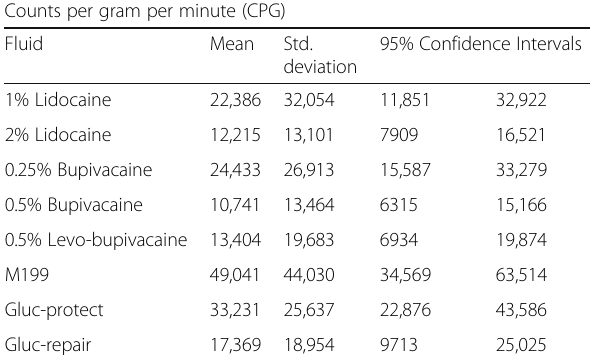
Table 2 Uptake of 35SO4 by articular cartilage specimens exposed to different local anaesthetic solutions, glucosamine and